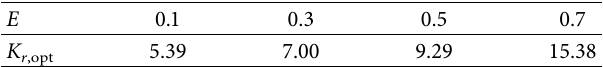
Figure 8: K � 0.5, δ � 0.2, δ � 0.1. o i r ,opt versus χ 2 for case O, E Table 5: Optimum conductivity ratio K r ,opt at different values of radius ratio χ 2 .